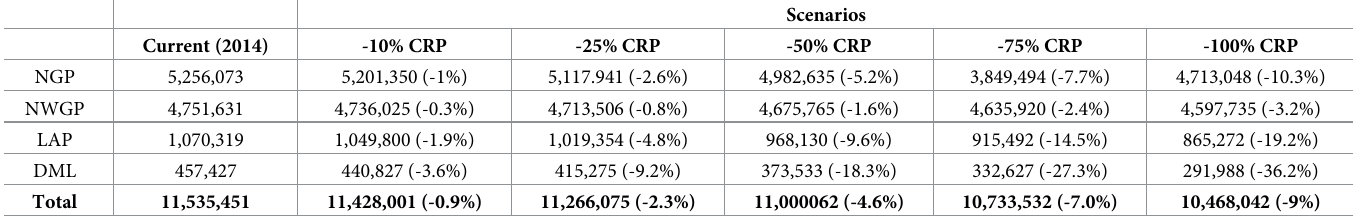
Table 4. Area (ha) of suitable grassland-bird habitat with a relative habitat-quality ranking � 0.3 on a maximum-scale value of 1.0 in the Northern Glaciated Plains (NGP), Northwestern Glaciated Plains (NWGP), Lake Agassiz Plain (LAP), and Des Moines Lobe (DML) ecoregions of the United States in the baseline year of 2014 and under five scenarios reflecting the conversion of 10%, 25%, 50%, 75%, and 100% of Conservation Reserve Program (CRP) grasslands to row crops. Values in parentheses represent the percentage of current (2014) suitable habitat lost under the different scenarios of CRP